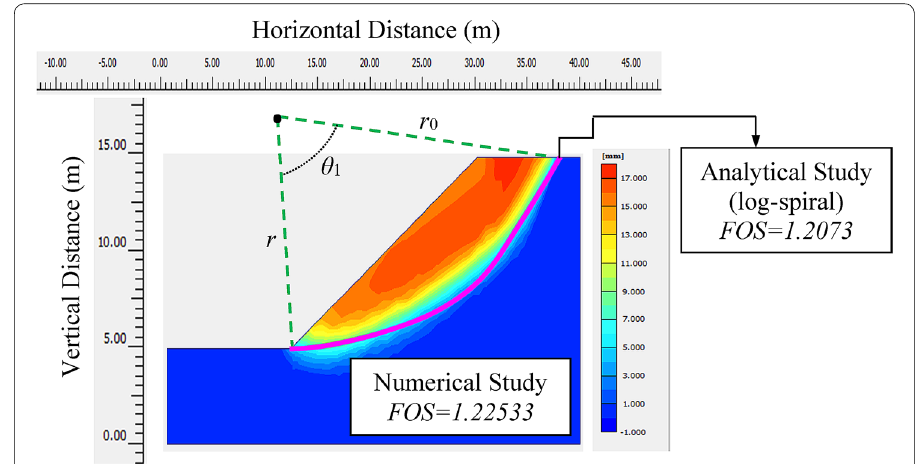
Fig. 18 Potential failure surface at β